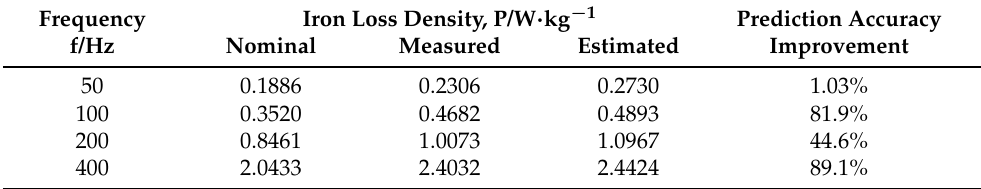
Table 2. Measured and calculated loss of samples after W-EDM at different frequencies.